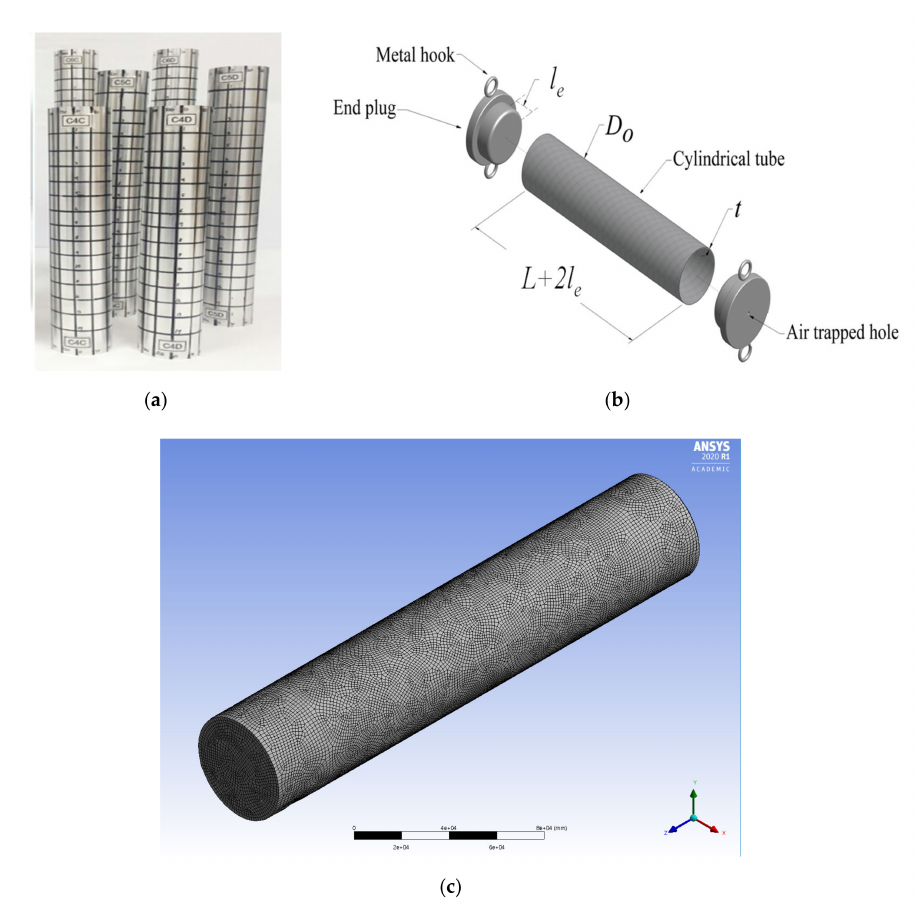
Figure 2. Cylindrical tube model (reproduced from [19], with permission from Pukyong National